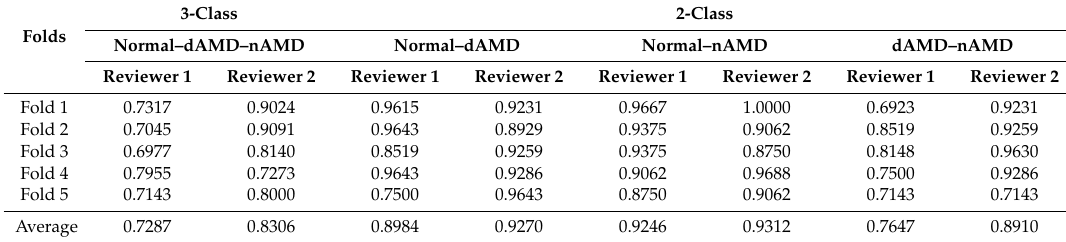
Table 6. Comparison of di ff erential diagnosis of AMD type between first- and fourth-year residents.